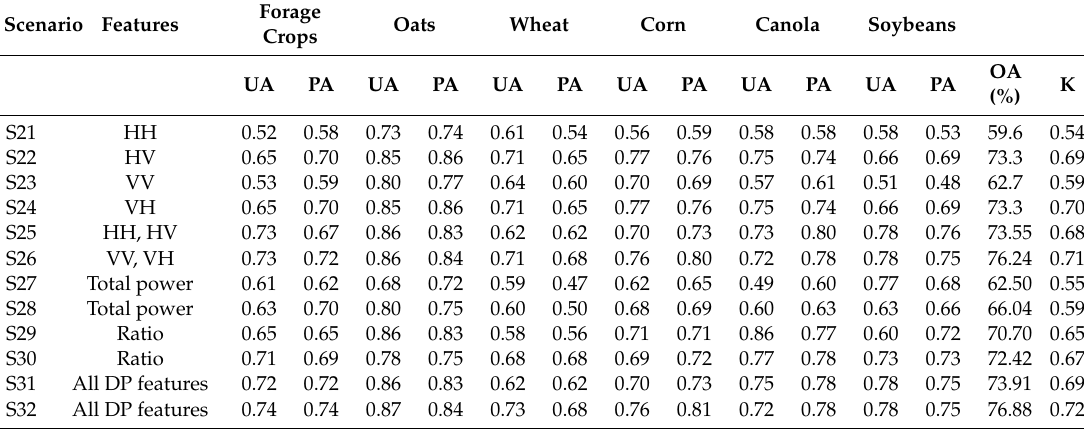
Table 7. Classification results obtained from extracted features from simulated DP SAR data at a noise floor (NF) of − 24